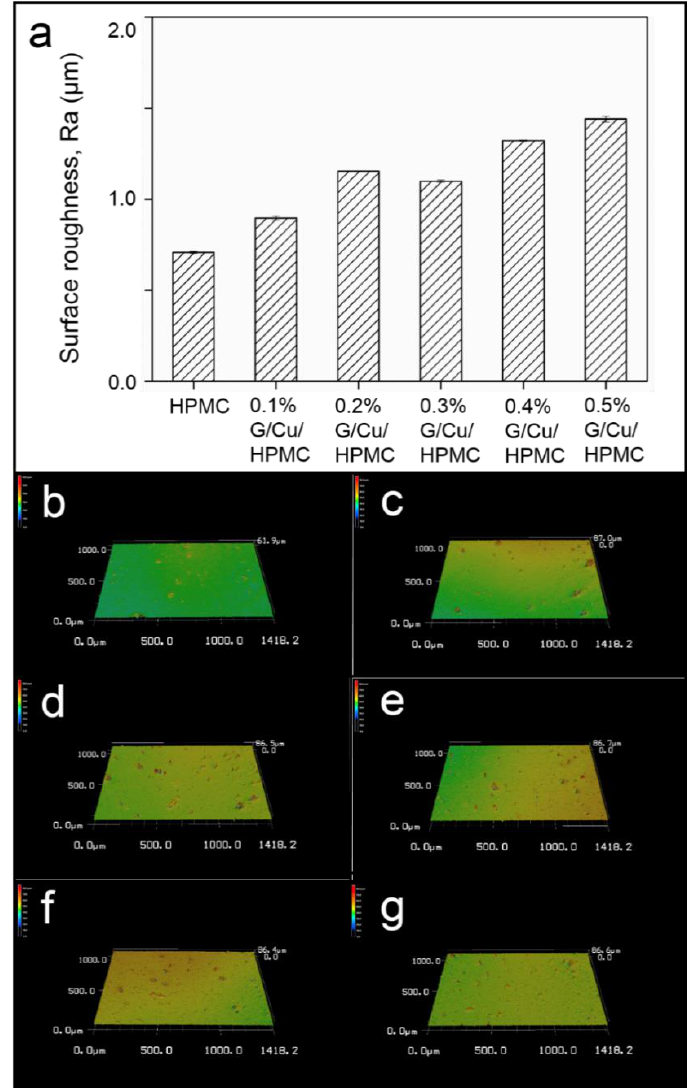
Figure 4. ( a ) Surface roughness ( R a ) of composite film; surface morphology of composite coating with ( b ) no additive, ( c ) 0.1% G/Cu, ( d ) 0.2% G/Cu, ( e ) 0.3% G/Cu, ( f ) 0.4% G/Cu, and ( g ) 0.5% G/Cu. Coatings 2020 , 10 , x FOR PEER REVIEW